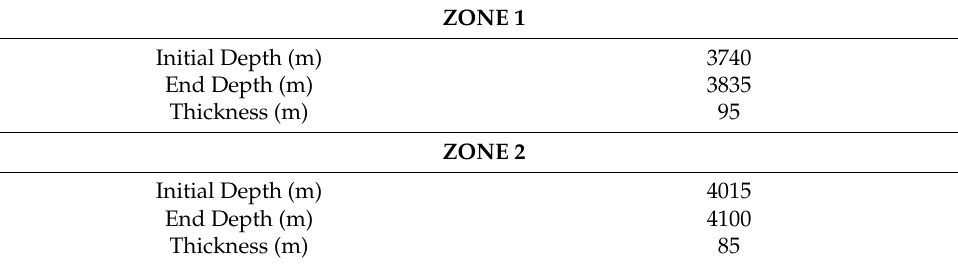
Table 6. Potential zones for hydrocarbon